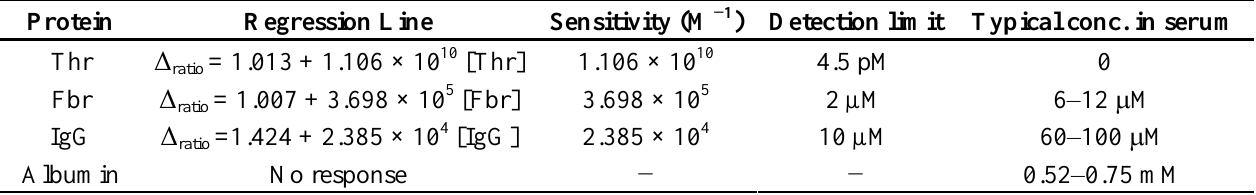
Table 1. Summary of calibration results for thrombin and other major proteins presents in